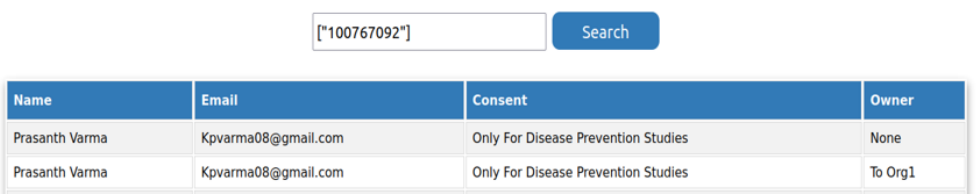
Figure 11. An access log of a user ’ s consent information.